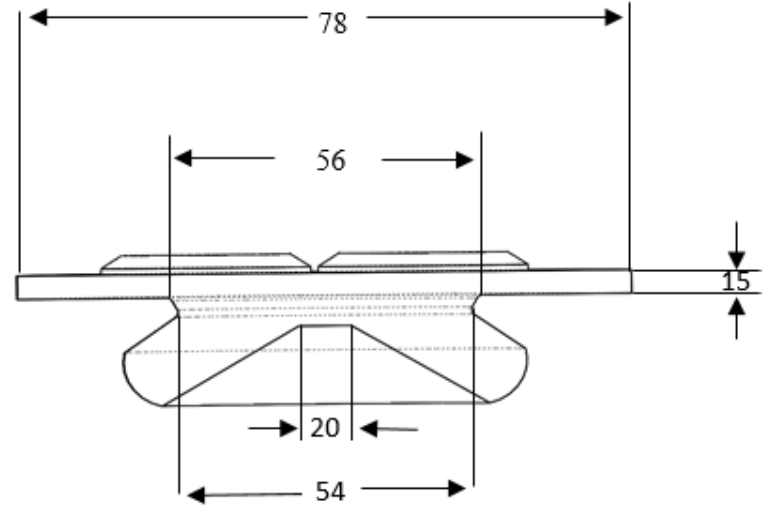
Figure 3. Schematic diagram for geometry design of the shallow depth re-entrance combustion chamber (SCC) piston bowl (unit in mm).